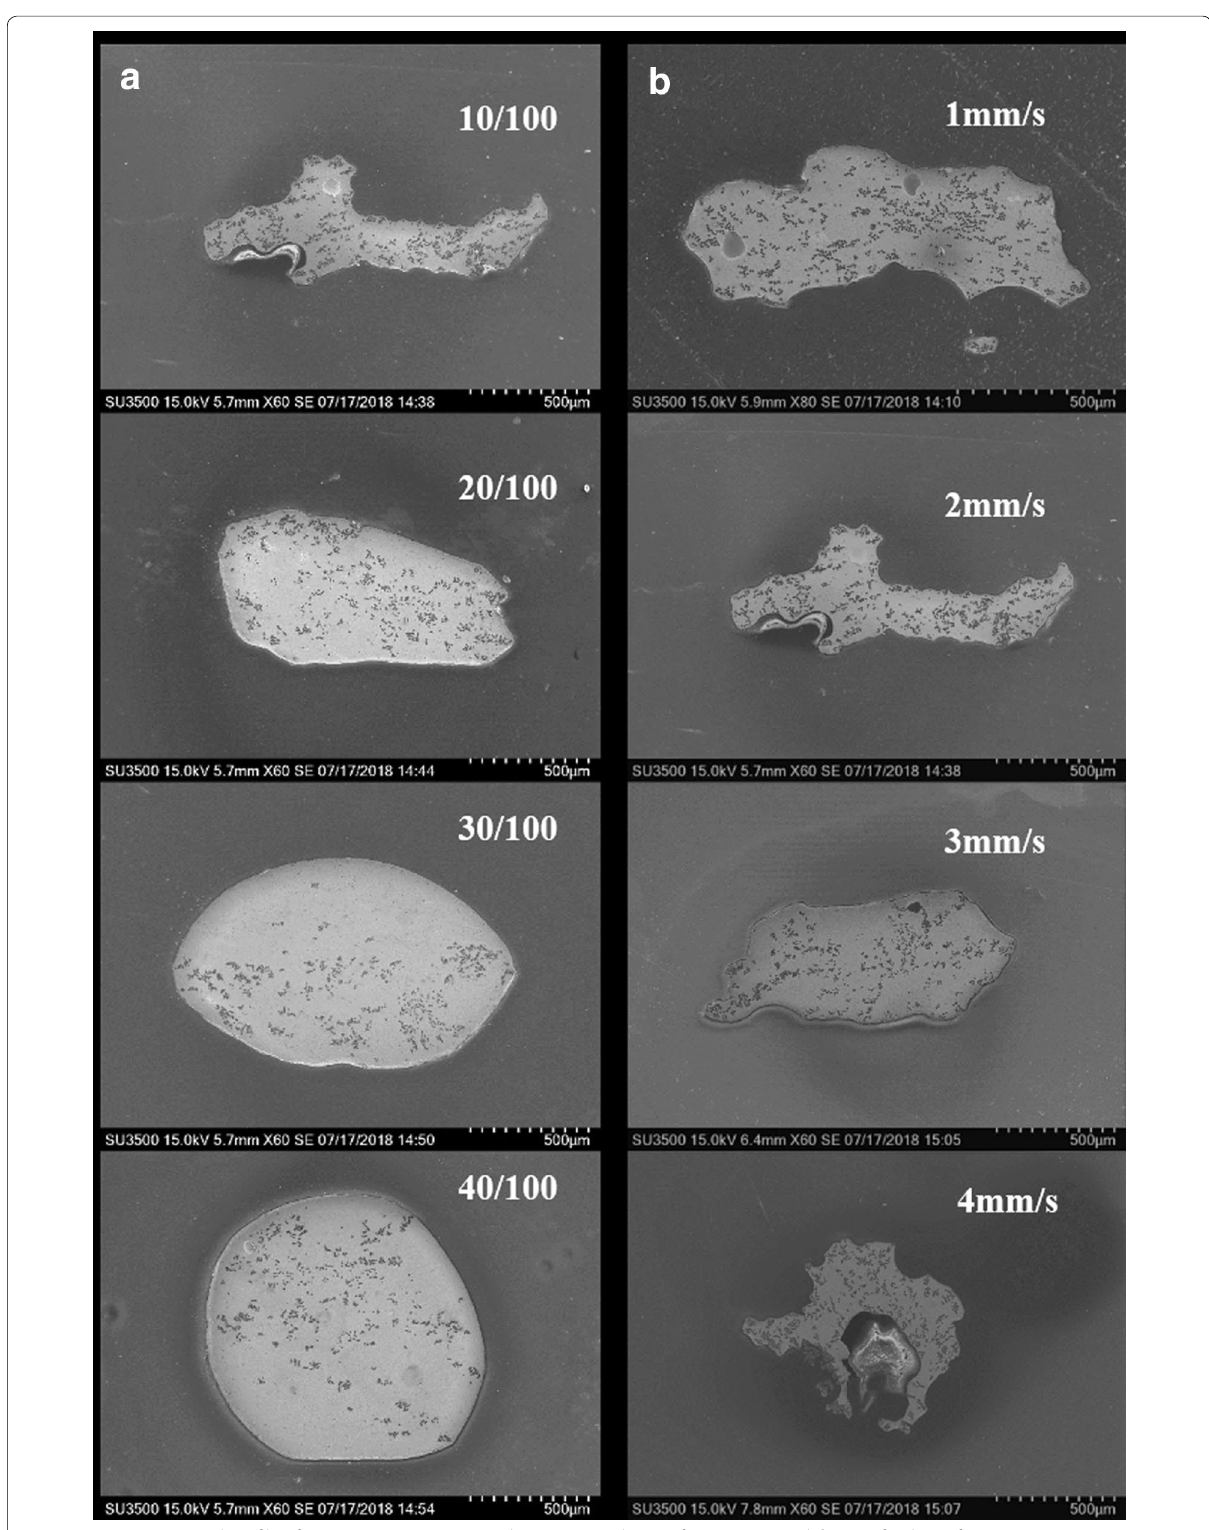
Figure 4 Cross-sectional profile of composite specimens at the printing velocity of ( a ) 2 mm/s and ( b ) wire feeding of